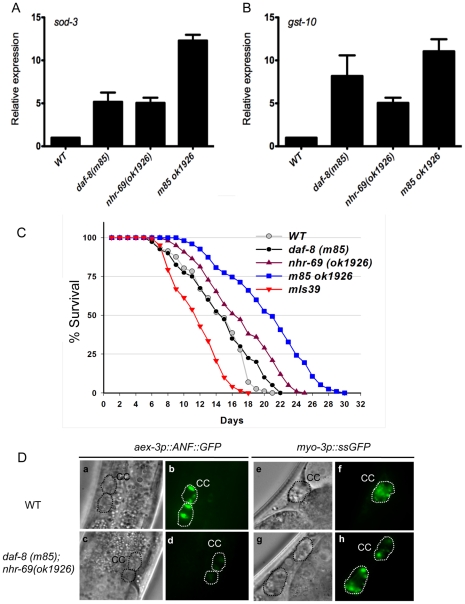
Reduced insulin signaling and neuropeptide secretion in daf-8 nhr-69 mutants.(A and B) Bar graphs show the relative mRNA levels of sod-3 and gst-10 in daf-8(m85), nhr-69(ok1926) and daf-8(m85) nhr-69(ok1926) mutants relative to wild-type worms, as determined by qPCR (normalized to act-2). Age synchronized day-1 adults were used for total RNA extraction. Error bars indicate SEM from three biological replicates. (C) The plots show population survival of wild-type (grey circles), daf-8(m85) (black circles), nhr-69(ok1926) (purple triangles), daf-8(m85) nhr-69(ok1926) (blue squares), and mIs39[nhr-69p::nhr-69::gfp] (red inverted triangles) worms at 25.5°C. (D) DIC and fluorescence micrographs show coelomocyte accumulation (CC, dotted circles) of ANF::GFP (expressed from the oxIs206[aex-3p::ANF::gfp] transgene; b and d) or ssGFP (expressed from the arIs37[myo-3P::ssGFP] transgene; f and h), respectively, in wild-type worms and in daf-8(m85) nhr-69(ok1926) mutants, as indicated.